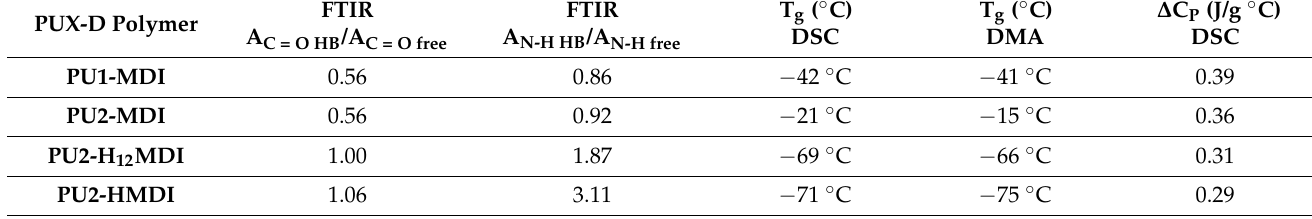
Table 3. FTIR ratio between peaks at 1710 cm − 1 (C=O HB ) and 1730 cm − 1 (C = Of ree ) and peaks at 3300 cm − 1 (NH HB ) and at 3460 cm − 1 (N-H free ), glass transition temperature (T g ), determined by differential scanning calorimetry (DSC) or dynamo-mechanical (DMA) analysis, and specific heat variation ( ∆ C p ). PTMO is the soft phase. PUX-D Polymer